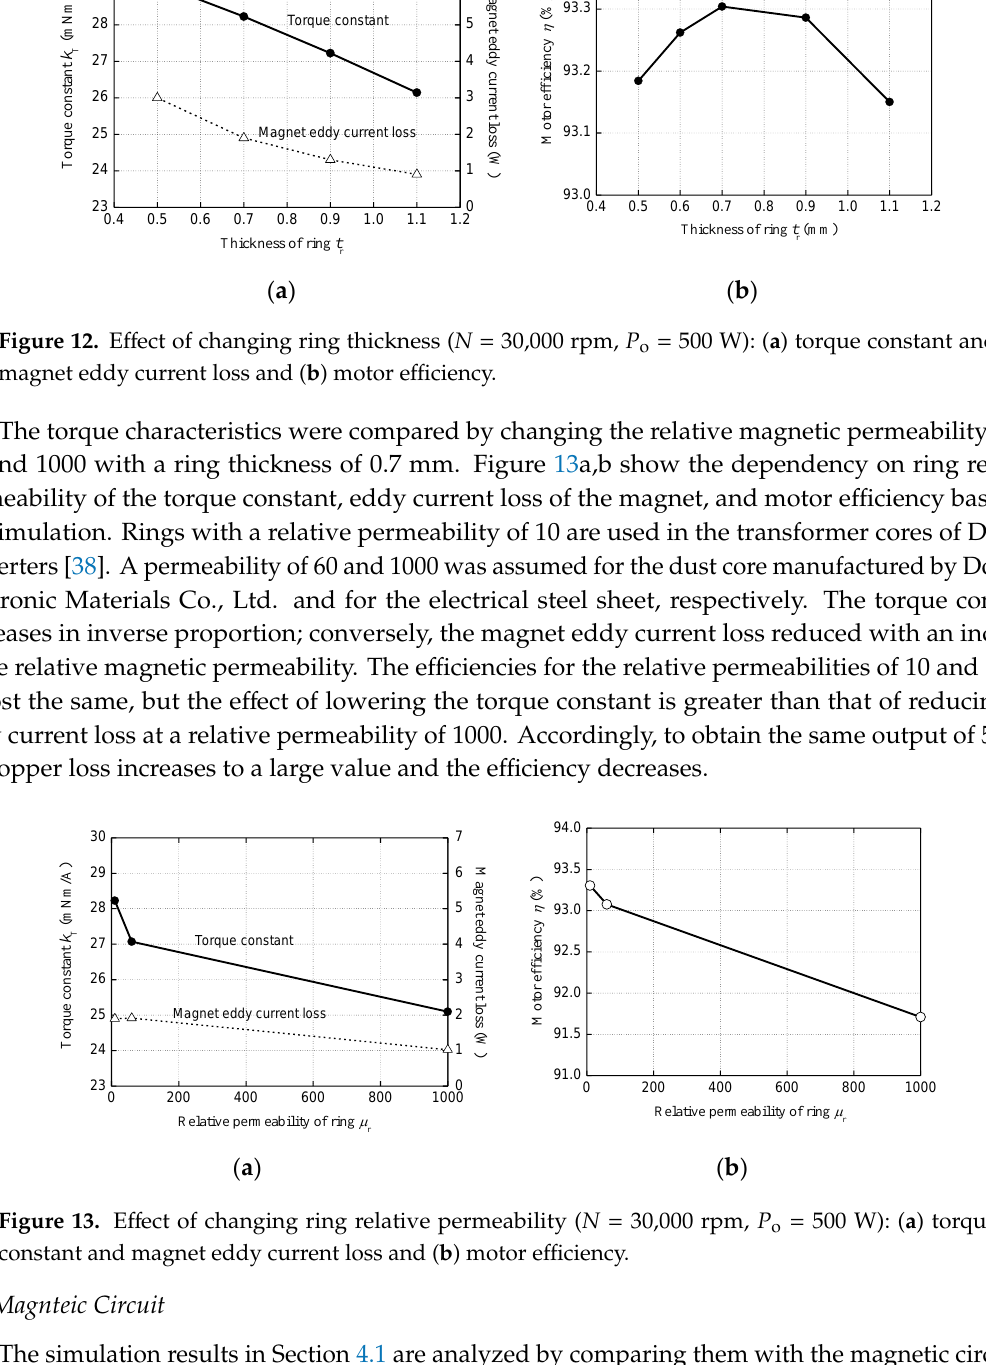
Figure 13. Effect of changing ring relative permeability ( N = 30,000 rpm, P o = 500 W): ( a ) torque constant and magnet eddy current loss and ( b ) motor efficiency.